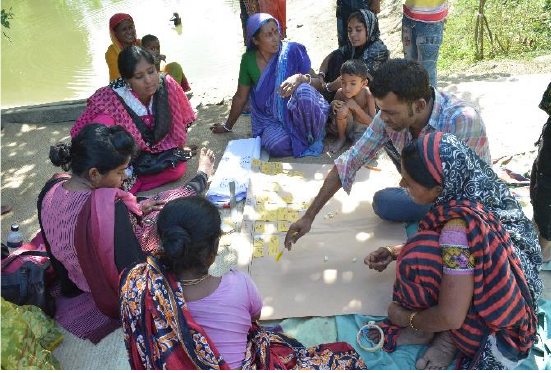
Figure 8: Community mapping, one community teaches another community how to map After finishing the housing project, the first community drainage system and proposed a